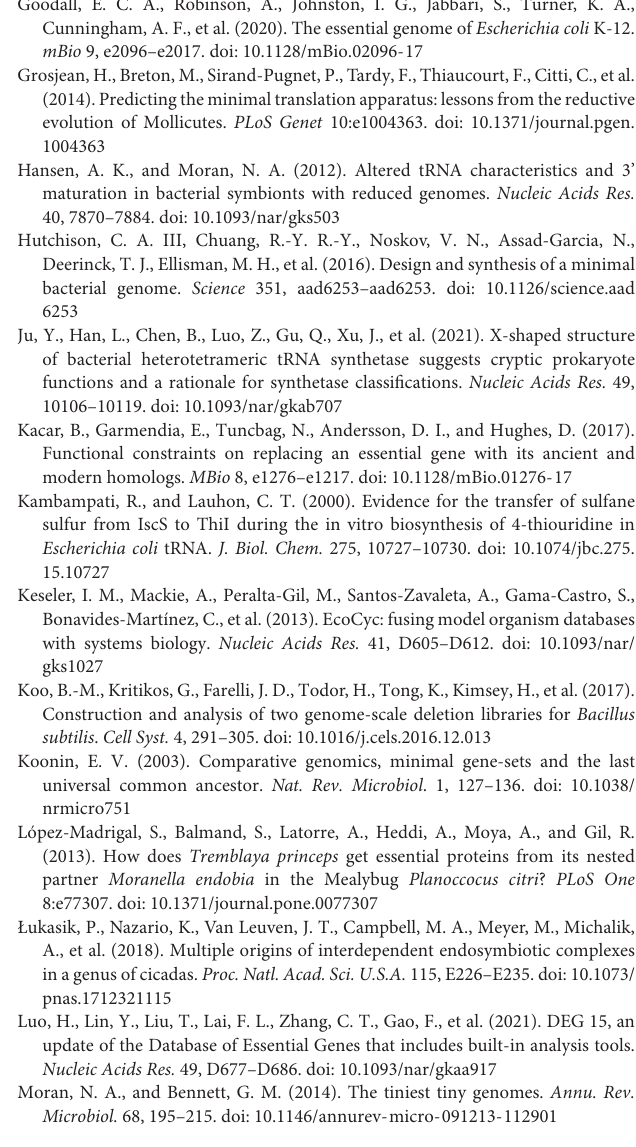
Supplementary Material 3 | Matrix of presence/absence of genes in the 92 genomes of the study (XLSX file). Zero values indicate absence of the gene. Supplementary Material 4 | Comparison among cosym, bcc , ssz , JCVI-syn3.0, and DEG datasets ( Escherichia coli and Bacillus subtilis ) used in the study